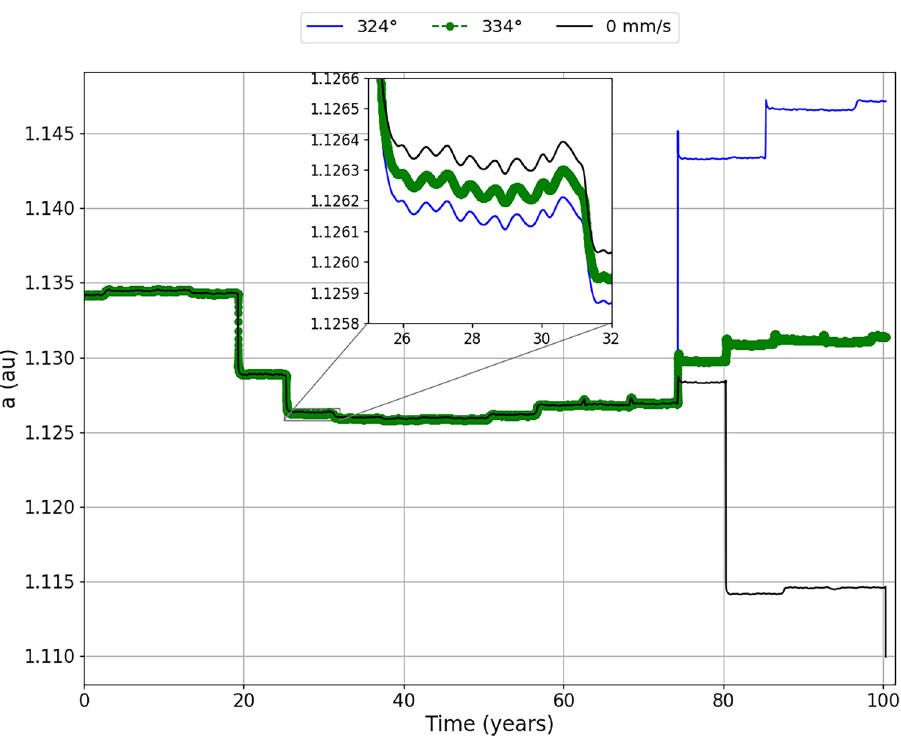
Figure 7. Evolution of the semi-major axis with respect to time for the impulse of −20 mm/s applied at the mean anomalies of 324° (blue line) and 334° (green line). We zoomed in on the region corresponding to